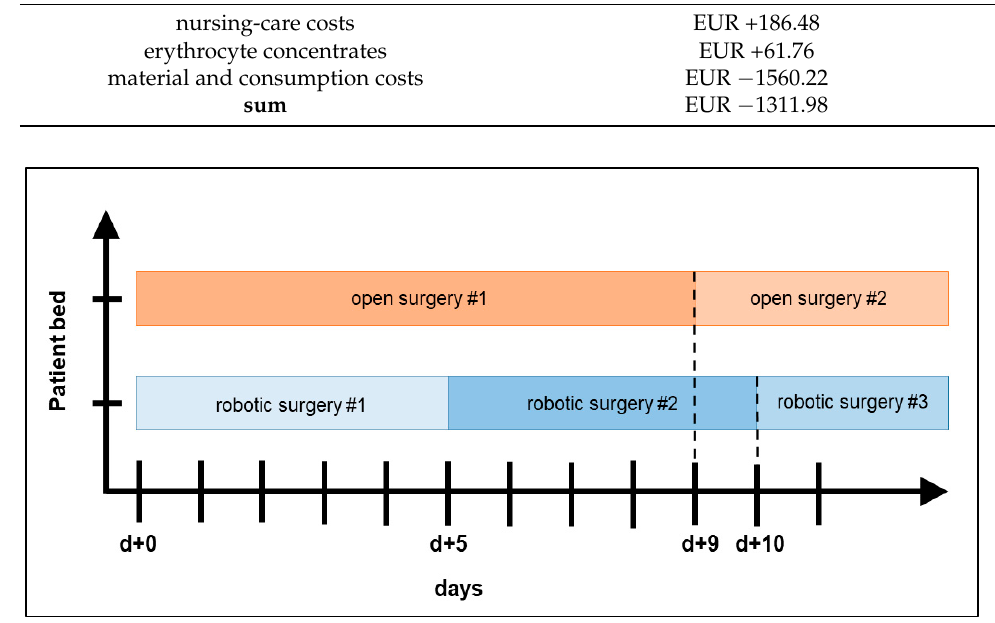
Figure 1. Comparison of robot-assisted vs. open partial nephrectomies from an occupancy-related perspective: in the case of ideal bed occupancy after robotic surgery, its shorter median length of stay enables additional revenue, since more patients can be operated on in the same period.